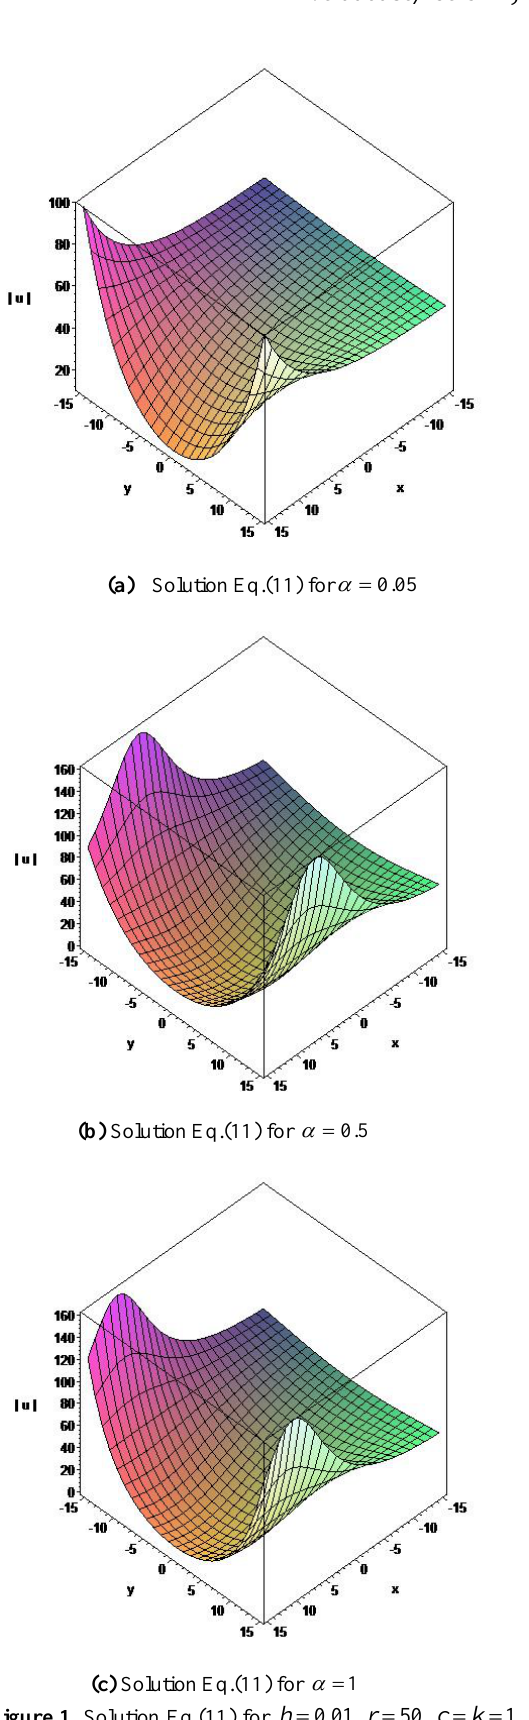
Figure 2. Solution Eq.(11) for 0.01, 50, h r = = 1, c k = = 5 y = and indicated 